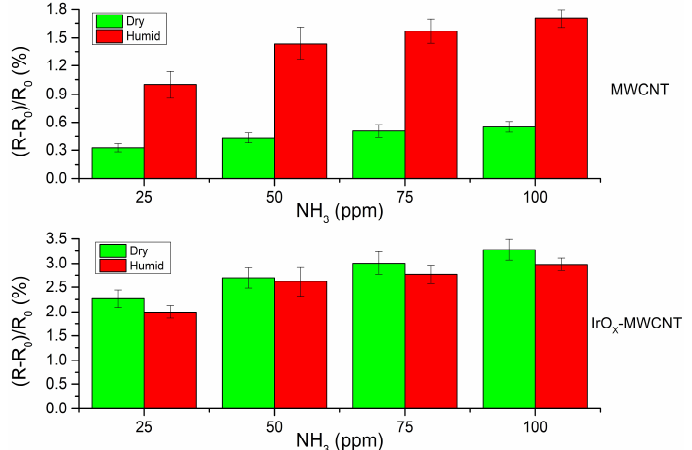
Figure 7. Comparison of the response towards ammonia for bare and IrO x -decorated MWCNTs under dry and humid (50% R.H.) conditions. Sensors were operated at 100 °C. For bare carbon nanotubes, the response towards ammonia shows a four-fold increase when under humid conditions. IrO x - MWCNTs present a slightly lower response to ammonia in humid conditions than in dry air.